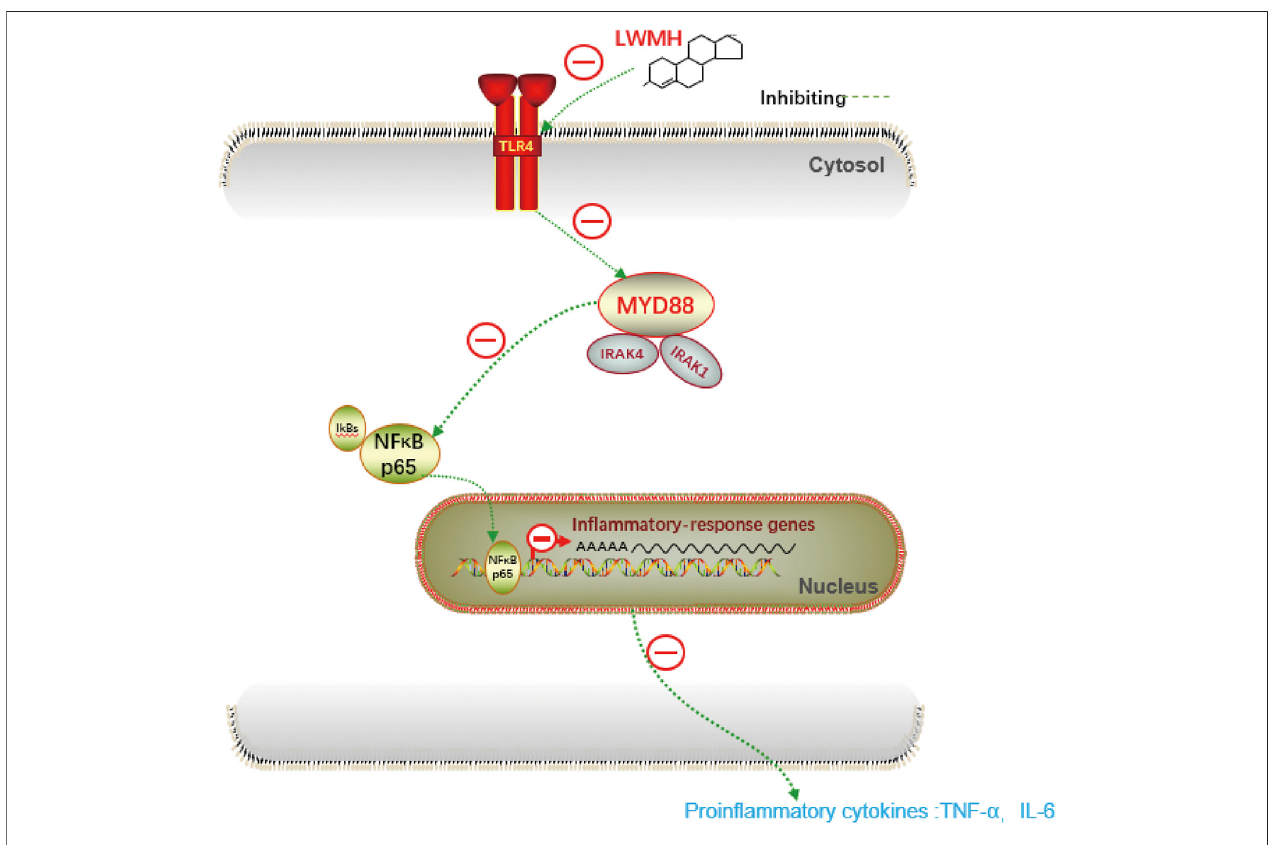
FIGURE 5 | Diagram for inhibition of TLR4-MYD88-NF- κ B by LMWH.